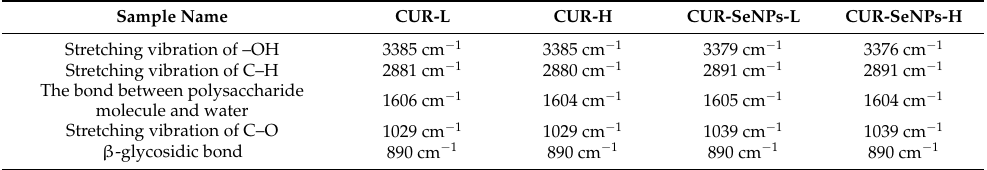
Figure 3. ( a ) The FTIR spectra and ( b ) XRD patterns of CUR-SeNP samples. Table 2. The differences in the main absorption peaks of stretching vibrations between